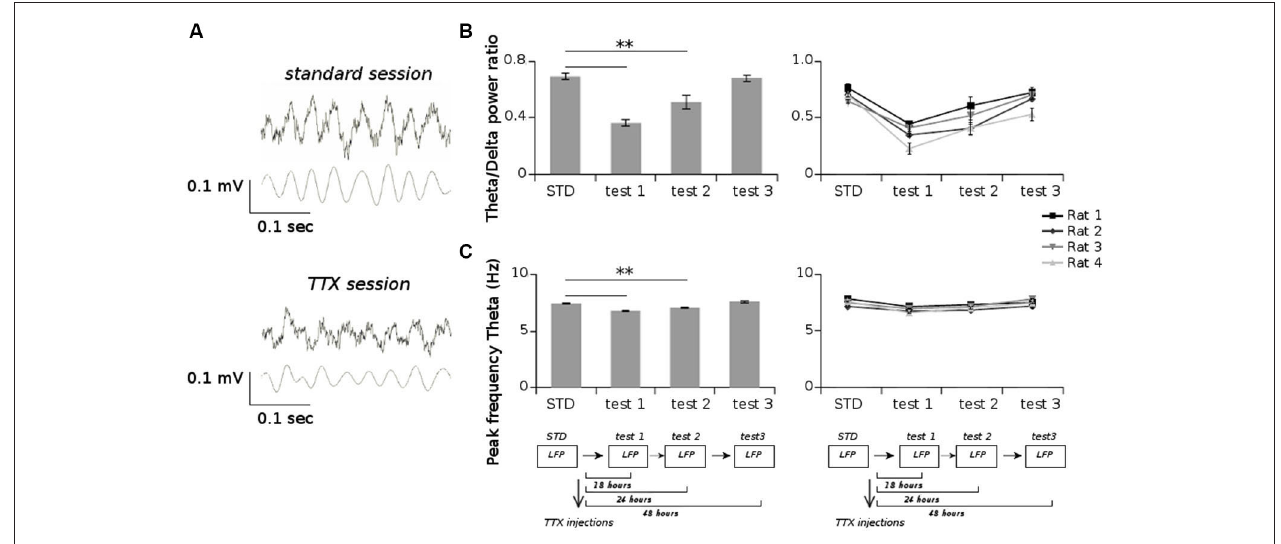
theta band (5–12 Hz) and in the delta band (1–4 Hz), for all sessions recorded before and after TTX administrations. (C) Average values of the peak frequency in the theta band for all sessions recorded before and after TTX administrations. ** p < 0.01, Tukey HSD